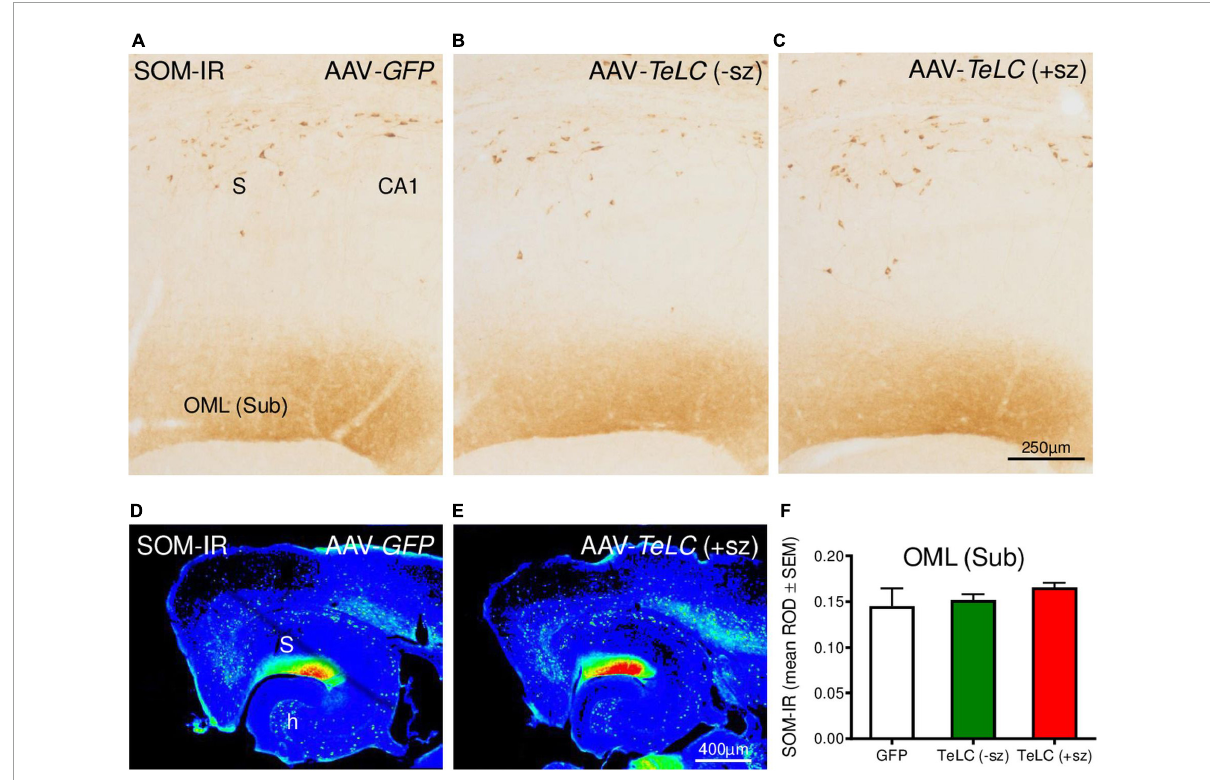
FIGURE8 SOM-IR after AAV- TeLC injection. SOM-IR in sector CA1 and subiculum of mice injected with AAV- GFP (A) or AAV- TeLC that were seizure-free (B) or had experienced SRS (C) . Note that neither the number of SOM-positive interneurons in the pyramidal layers of the subiculum (S) and sector CA1 nor the density of SOM-positive axon terminals in the outer molecular layer (OML) of the subiculum was altered. Panels (D,E) show false color images of panels (A,C) , respectively. (F) Mean ROD values of the molecular layer were not altered by previous SRS. +sz, mouse with previous seizures; -sz, mouse was